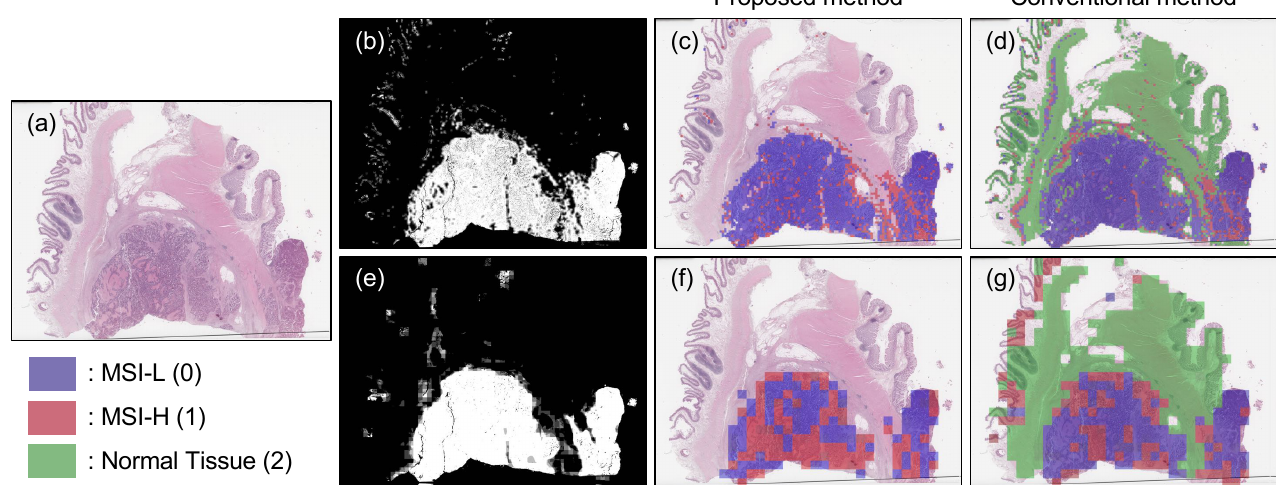
Figure 5. Patch-wise classification results of the MSI-L tissue, which were predicted as MSI-L for both the proposed and the conventional method. ( a )The original WSI. The segmented tumor mask and the heatmap created using the proposed method and the conventional method with images at 20 × magnification( b – d ) and 10 × magnification( e – g